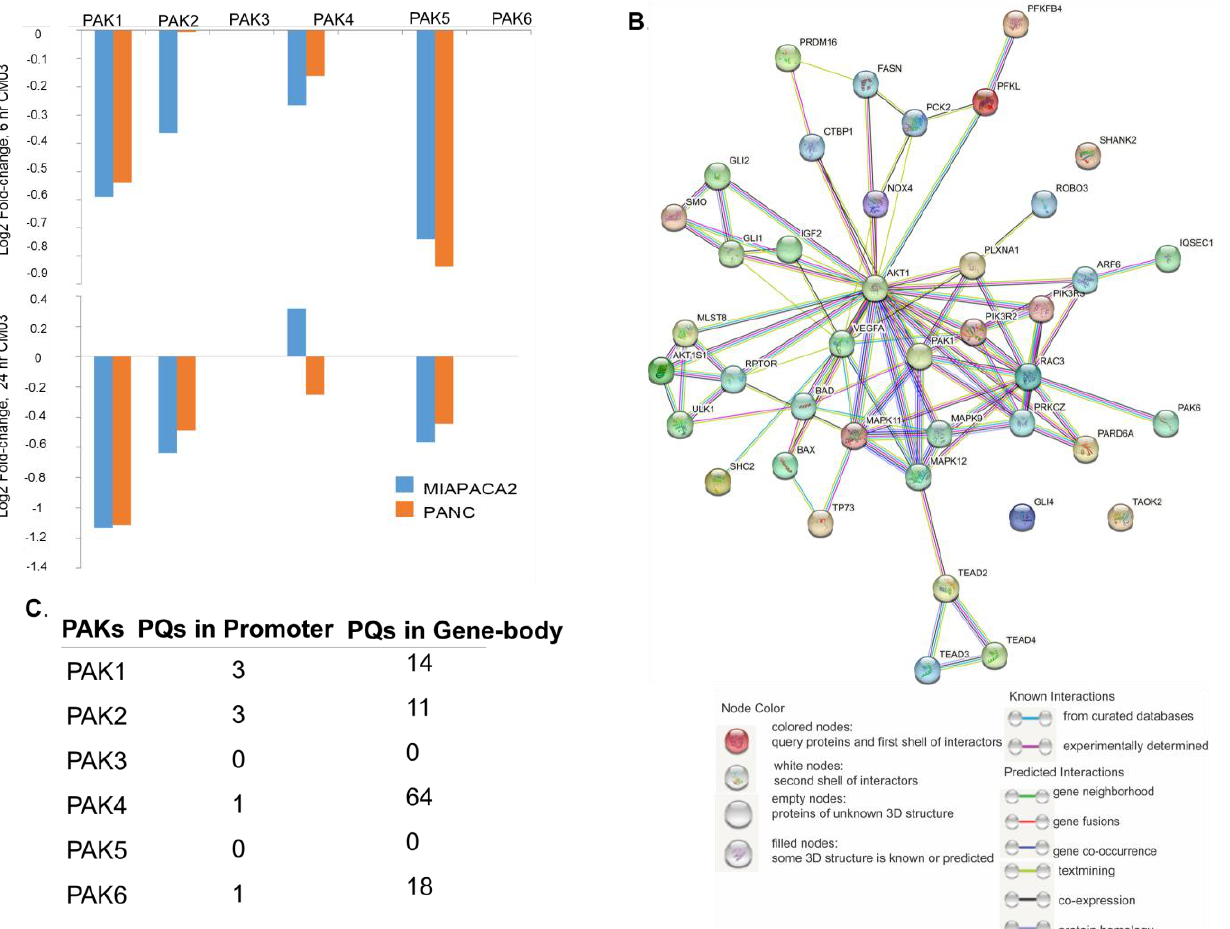
Figure 4. G4 ligands downregulate the expression of PAKs. ( A ) The levels of PAKs in CM03-treated pancreatic cancer cell lines previously reported in Marchetti et al. [113]; ( B ) Protein–protein interaction network among PAKs and other top downregulated genes in G4 ligand CM03 − treated pancreatic cancer cells lines in Marchetti et al. [113] using STRING database [117]; ( C ) Number of G quadruplex in promoter regions within 1kb of TSS and the gene body of PAK family using the G4 mapping tool Quadebase2 [120].